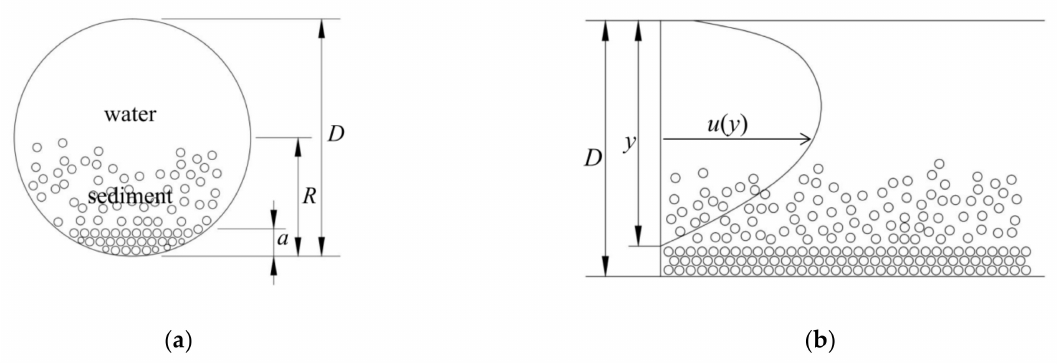
Figure 6. Schematic diagram of water–sediment two-phase flow in the pipe: ( a ) section; and ( b ) longitudinal.